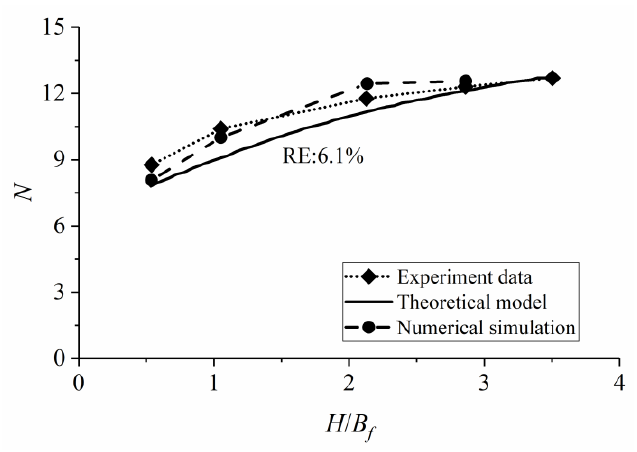
Figure 14. Comparative study on the capacity factor in linear clay [16,50,51].